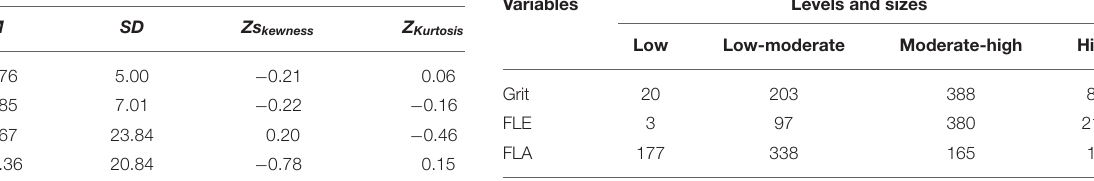
TABLE 2 | Means, standard deviations, Z-standardized values of skewness and kurtosis of the key variables. M Zs kewness